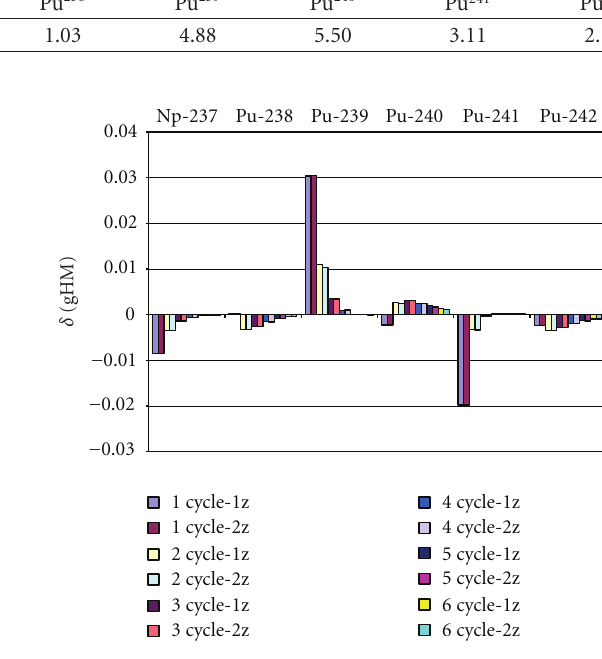
Figure 8: Production/destruction of some Np and Pu nuclides per initial HM mass in the di ff erent GCFR core models, for each